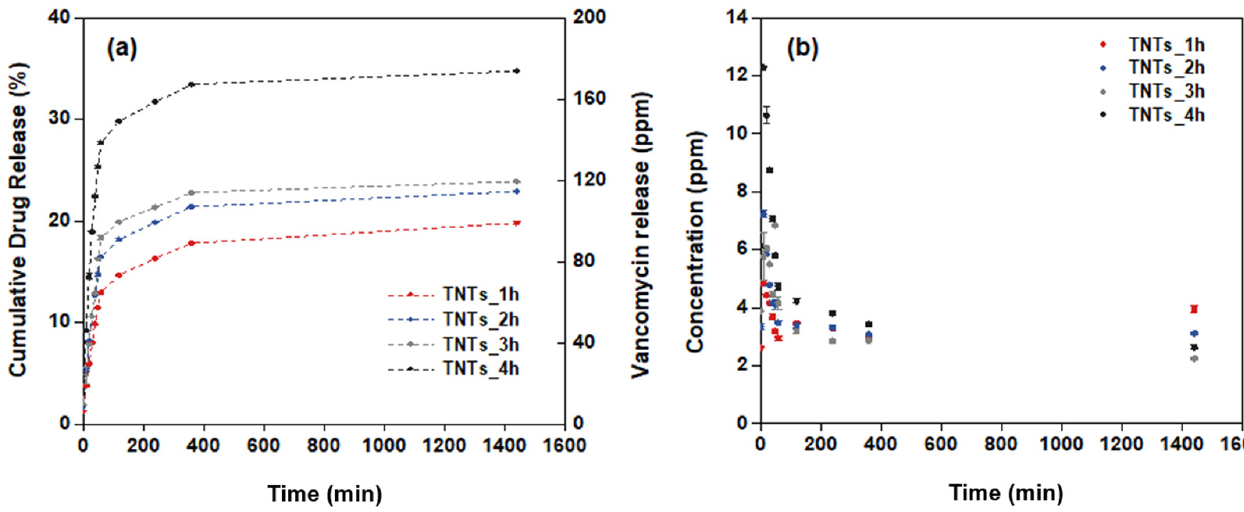
Figure 7. Drug release profiles of ( a ) the percentage of cumulative drug release and ( b ) the concentration of drug release at different anodization time of the titanium oxide nanotubes.